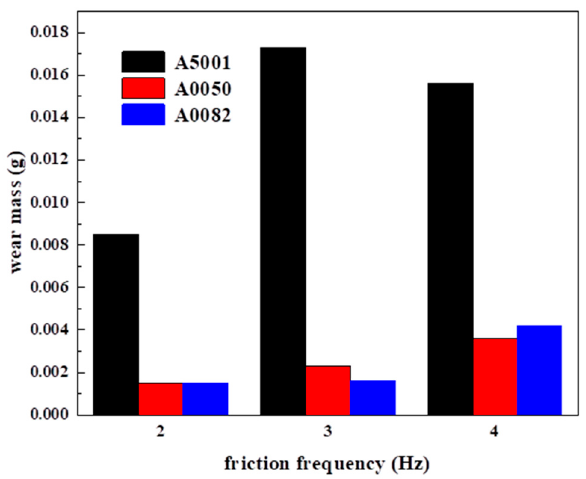
Figure 7. Comparison of wear loss of coatings prepared by different materials at different friction frequencies.